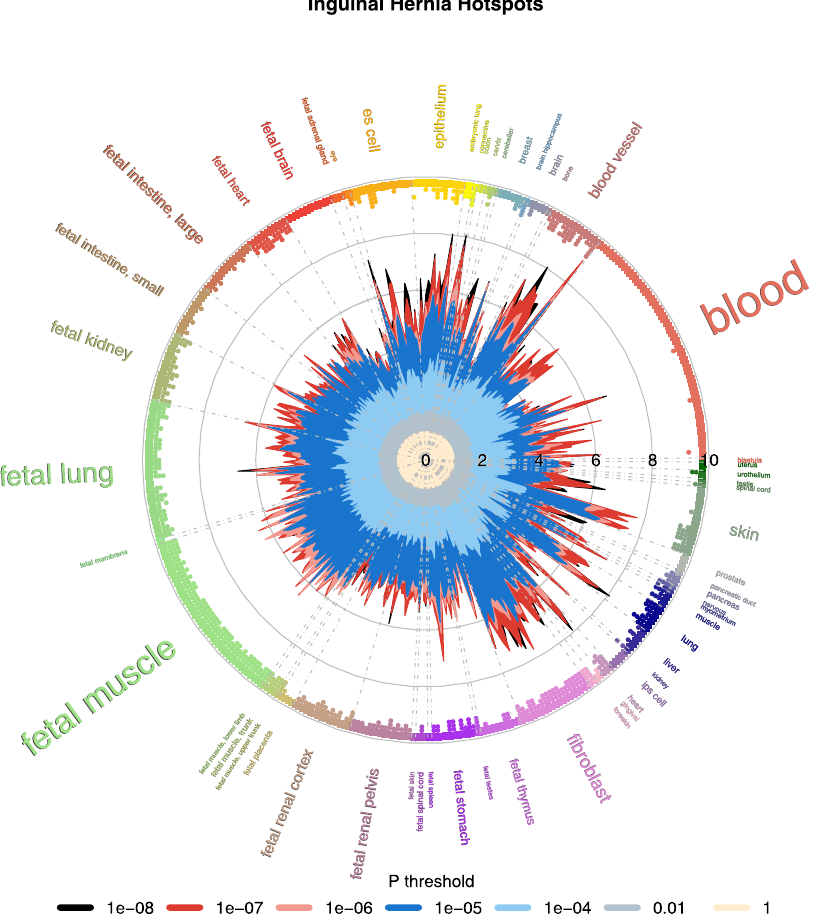
Fig. 5 GARFIELD hotspots enrichment for inguinal hernia. Enrichment wheel plot from the GARFIELD hotspots analysis for inguinal hernia. The radial spikes display the odds ratios for the tissues noted on the outside at seven P value thresholds (color codes below the plot) for all ENCODE and Roadmap Epigenomics DHS cell lines. The dots just inside the outer circle denote signi fi cant (correcting for the number of effective annotations) GARFIELD enrichment separately for each of the fi ve thresholds from 1 × 10 − 4 to 1 × 10 − 8 .